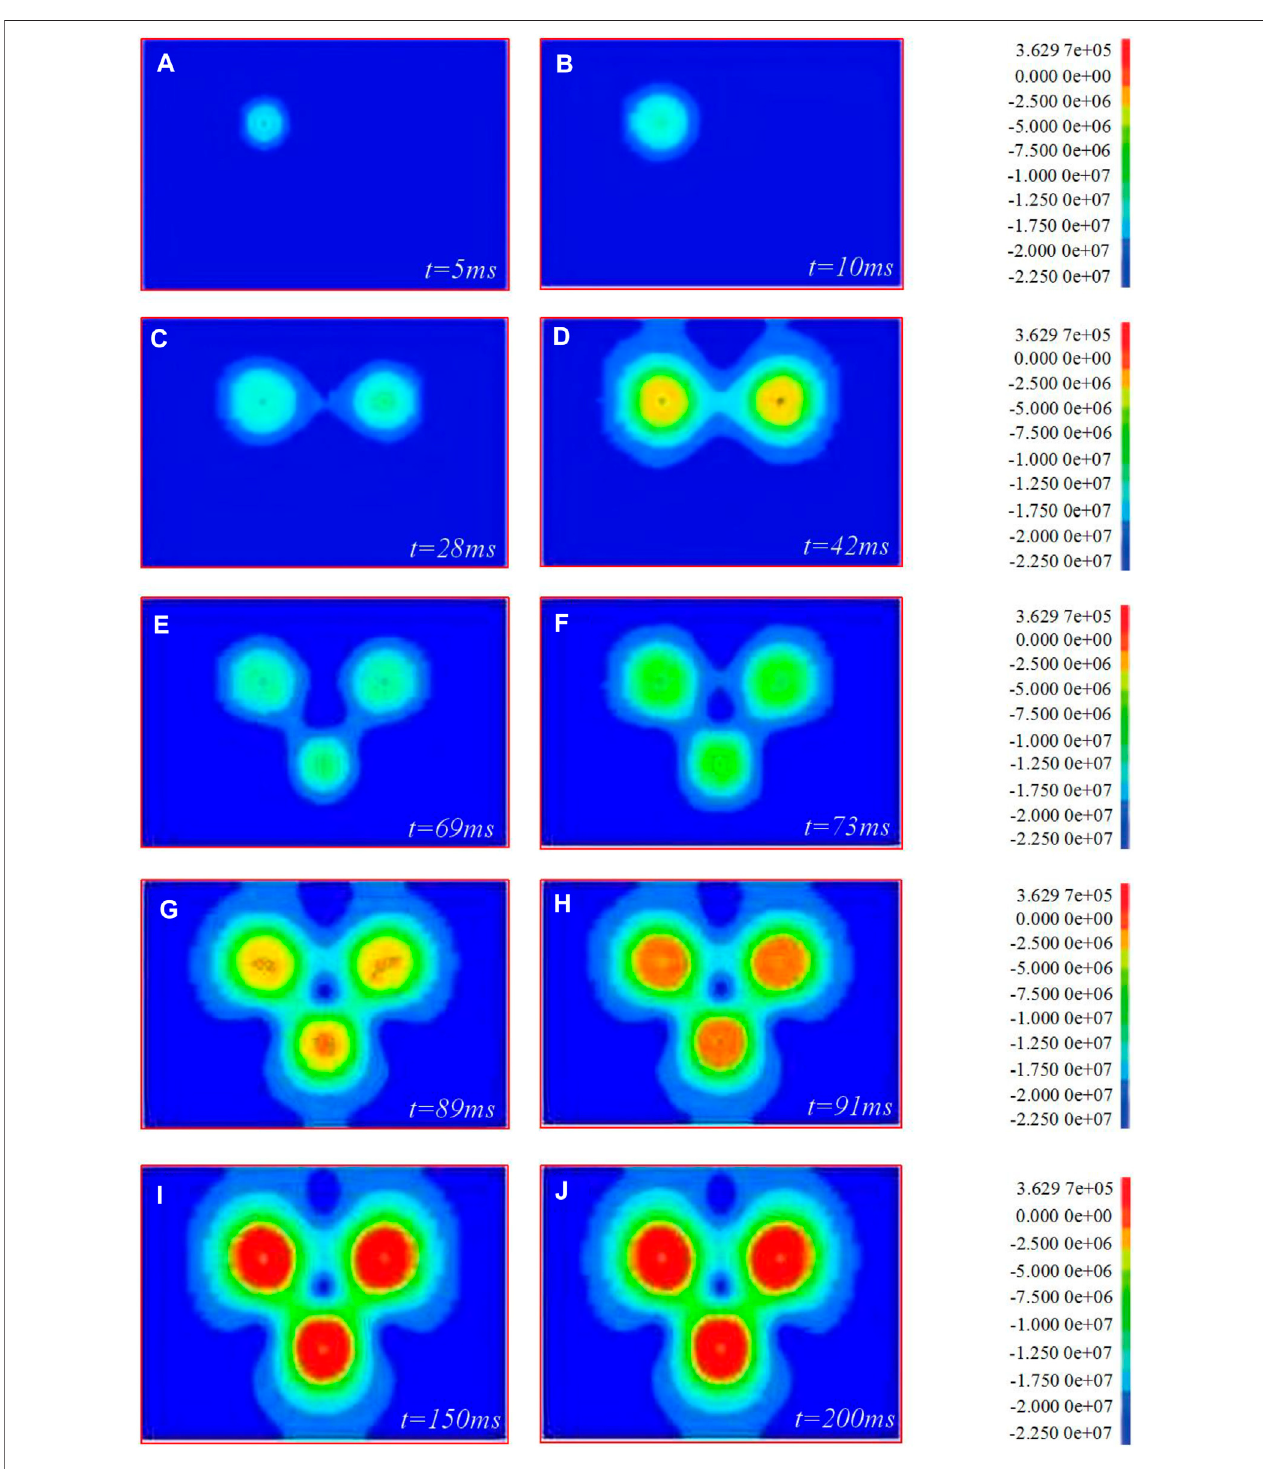
FIGURE5| Thepropagationprocessofstresswaveinwideholespacingblasting. (A – J) arestresseswavepropagationeffectoft (cid:2) 5 ms,t (cid:2) 10 ms,t (cid:2) 28 ms,t (cid:2) 42 ms, t (cid:2) 69 ms, t (cid:2) 73 ms, t (cid:2) 89 ms, t (cid:2) 91 ms, t (cid:2) 150 ms and t (cid:2) 200 ms, respectively.